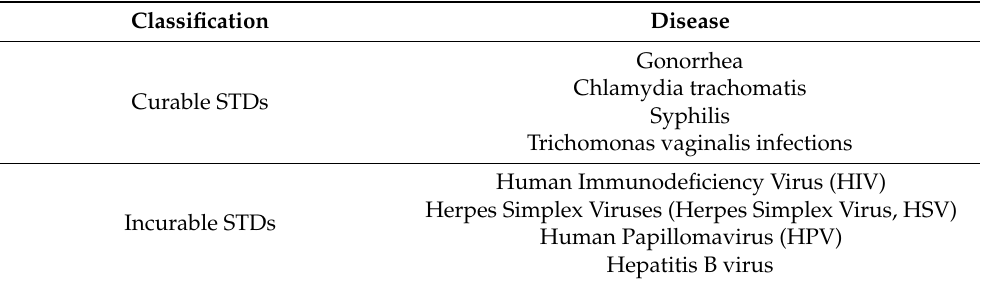
Table 17. Curable disease and incurable disease